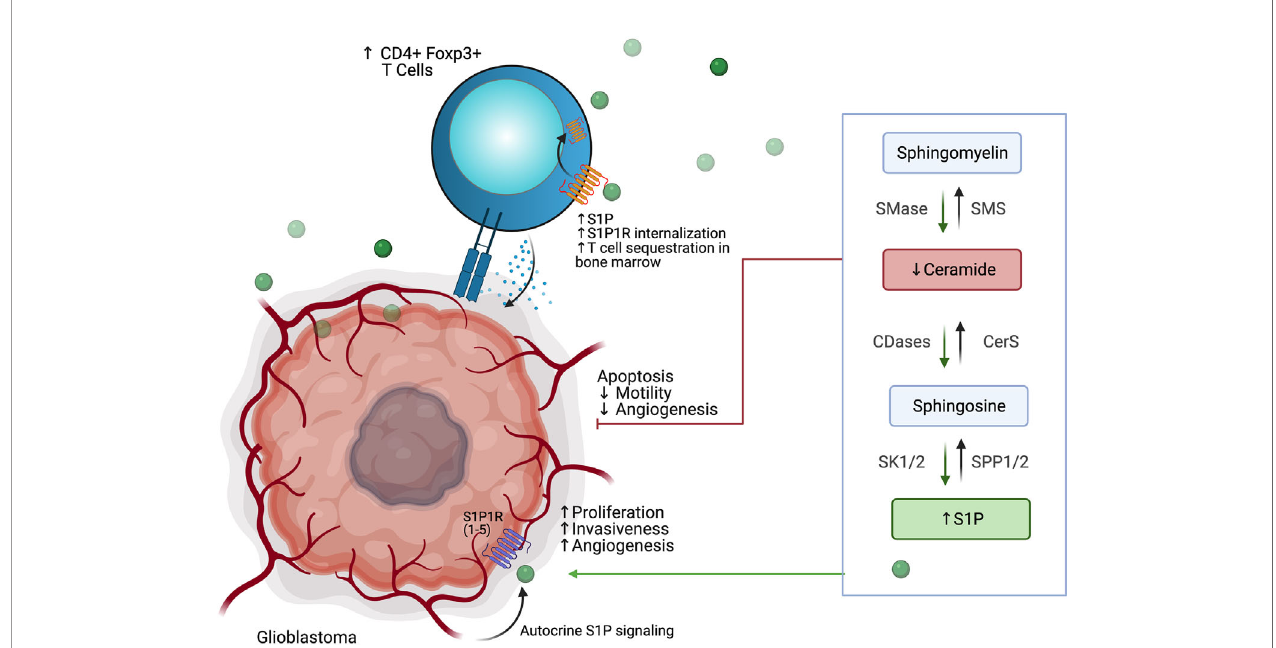
FIGURE 7 | Glioblastoma cells use altered phospholipid metabolism to induce tumor proliferation, invasiveness, and angiogenesis while sequestering T cell populations away from the tumor